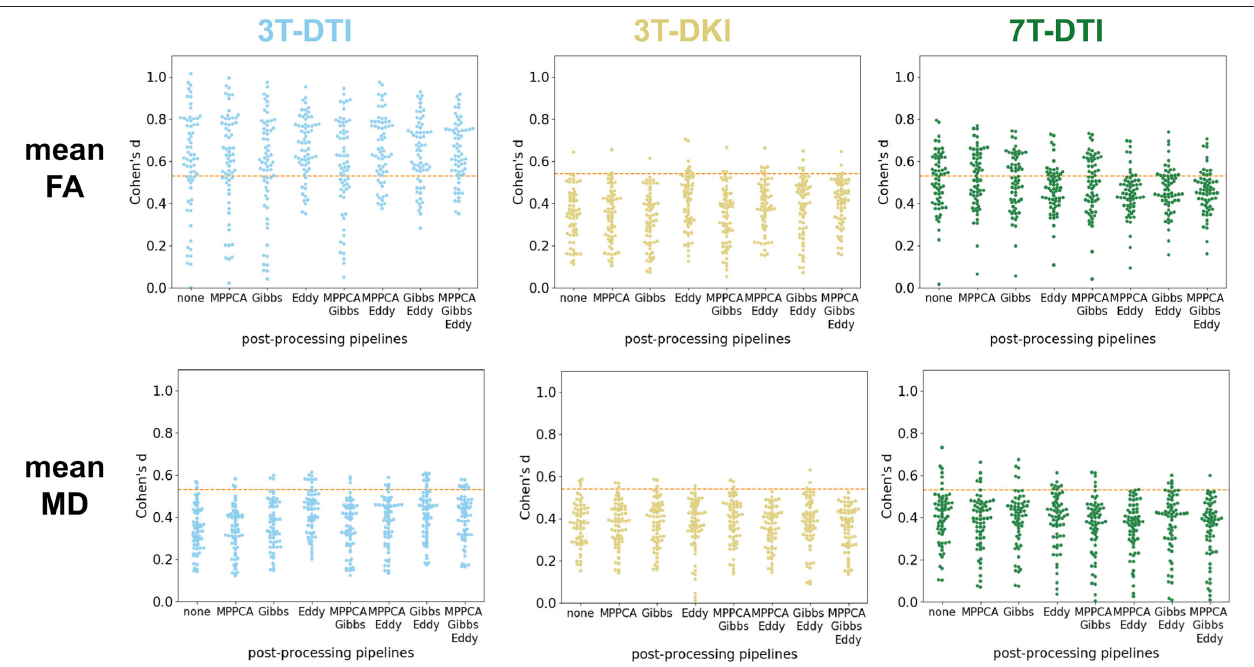
FIGURE 5 | Impact of the processing pipeline. The impact of the processing pipelines (x-axis) is evaluated through effect size estimates (Cohen’s d scores, y-axis). Top row: effect size estimates in mean fractional anisotropy (FA) from 3T-DTI (top left), 3T-DKI (top center), and 7T-DTI (top right). Bottom row: effect size estimates with mean diffusivity (MD) from 3T-DTI (top left), 3T-DKI (top center), and 7T-DTI (top right). No smoothing was applied. Each dot represents one tract. An orange dotted line in each plot defines the threshold in effect size above which the result is considered significant.